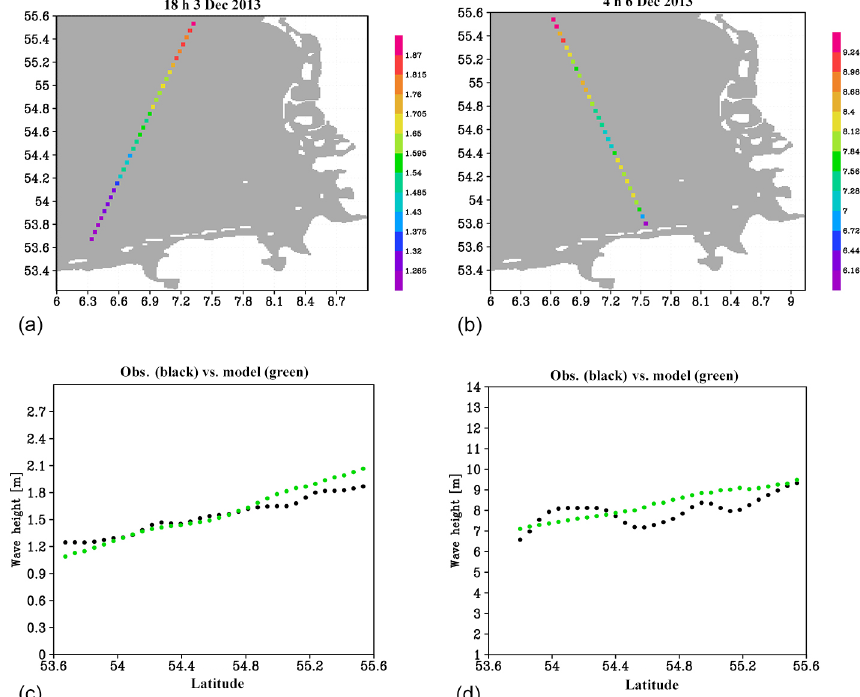
Figure 6. Along-track observed and modelled significant wave heights (m). (a) SARAL/AltiKa ground track for overflight in calm conditions on 3 December 2013 at 18:00UTC in colours are observed altimetric significant wave heights (m), (b) same as (a) but during storm Xaver on 6 December 2013 at 04:00UTC, (c) observed (Obs.,black) and modelled from WAM model (green) significant wave height (m) on 2 December 2013 at 18:00, (d) same as (c) but during storm Xaver on 6 December 2016 at 04:00UTC.